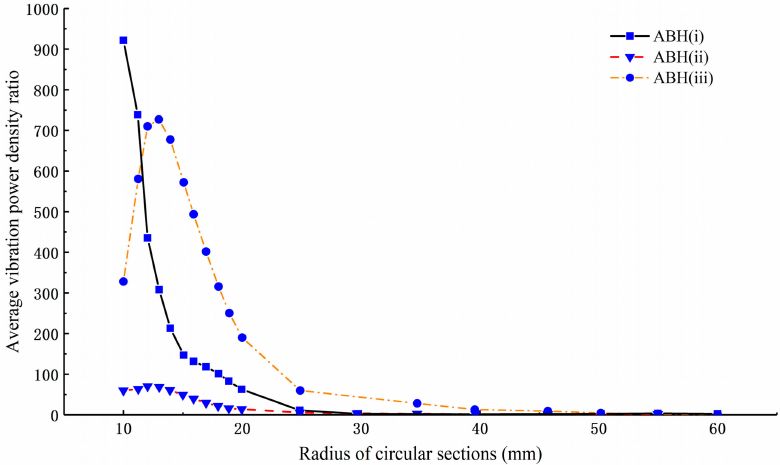
Figure 8. Average vibration power density ratios at excitation frequencies of 1002 Hz.